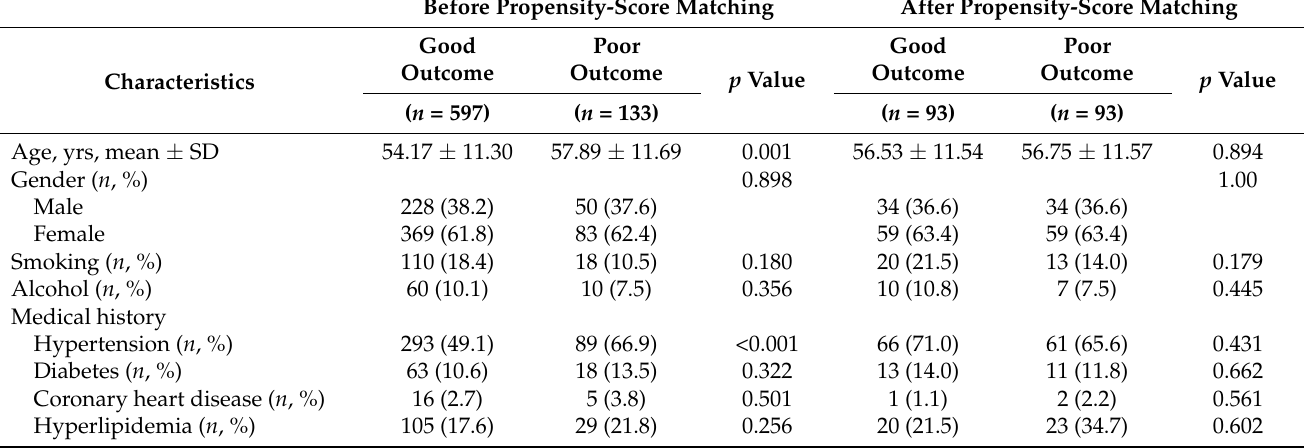
Table 3. Univariate analysis of association with outcome in aSAH before and after propensity-score